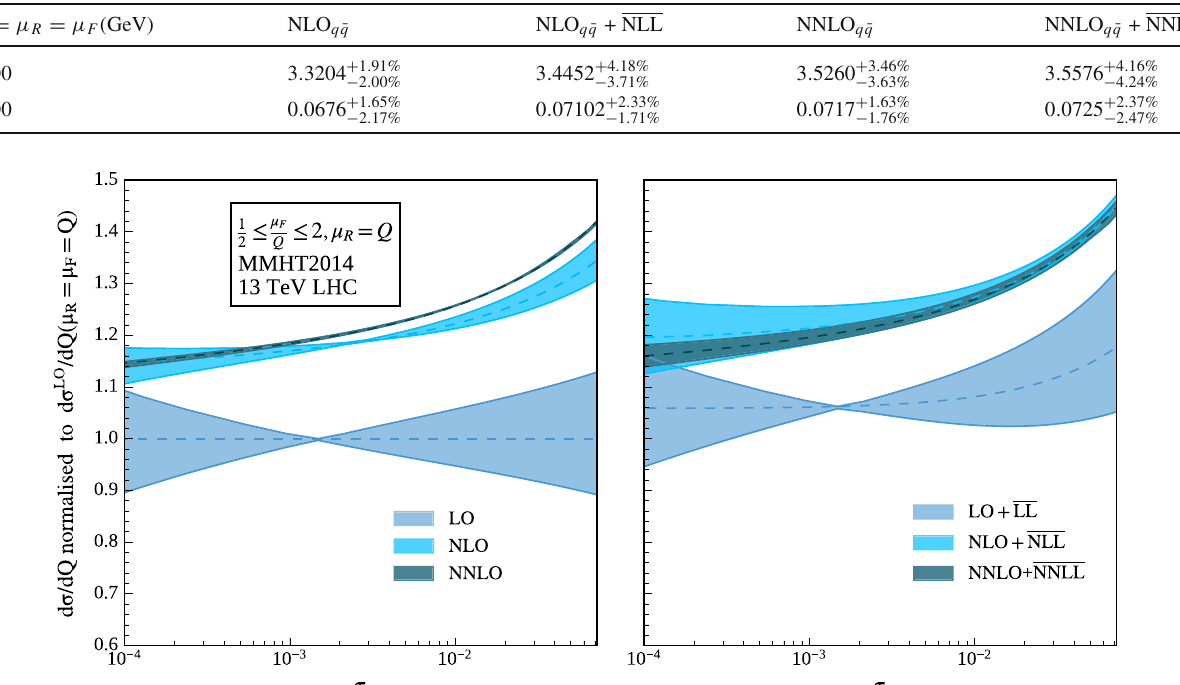
Fig. 4 7-point scale variation of the resummed result against fixed-order around the central scale choice (μ R ,μ F ) = ( 1 , 1 ) Q for q ¯ q channel Table 7 Values of resummed cross section at various orders in comparison to the fixed-order results in 10 − 5 pb/GeV for q ¯ q channel at different central scales Q = μ R = μ F = 1000 and 2000 GeV for 13 TeV LHC